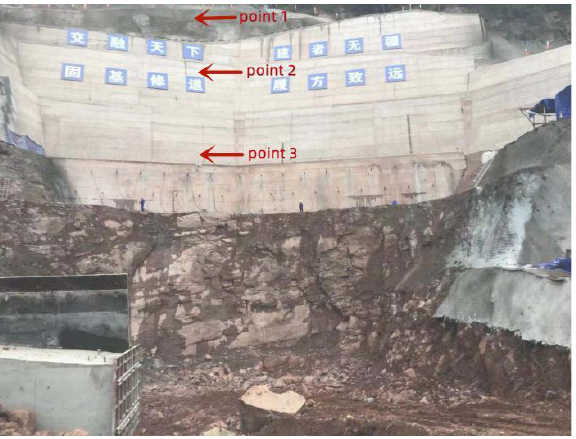
Figure 29. Construction layout of the blasting vibration monitoring points. Table 7. The distance between test points and blasting sources.